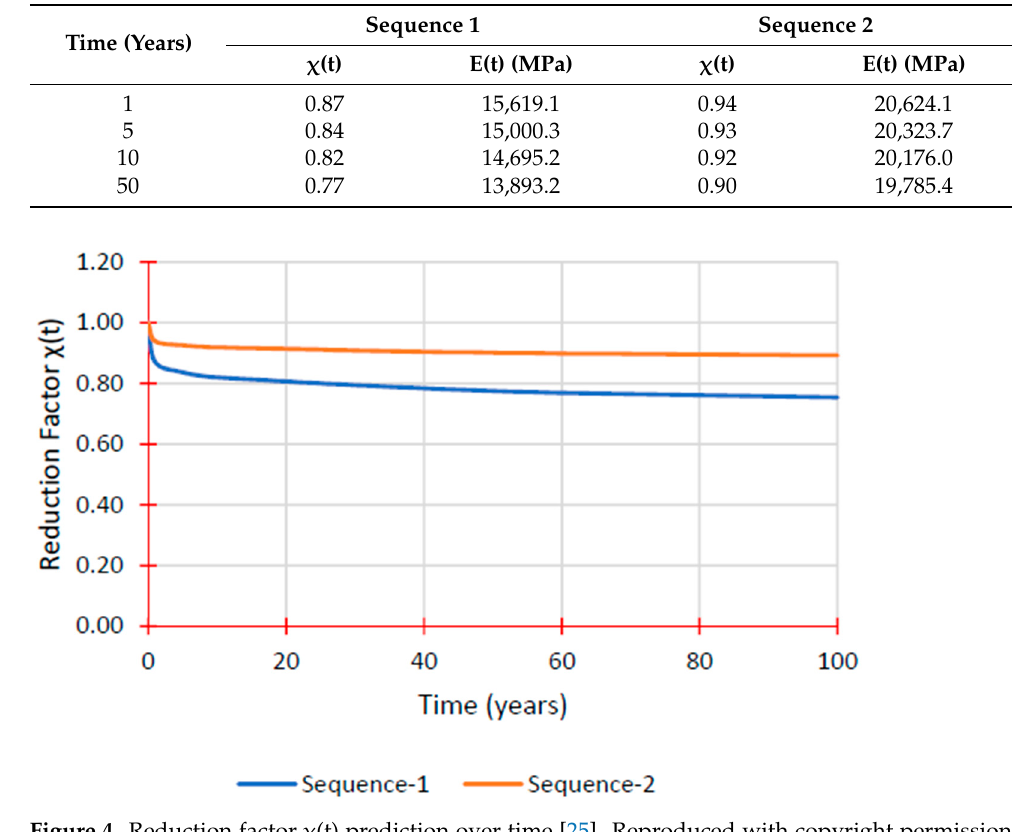
Figure 4. Reduction factor χ (t) prediction over time [25]. Reproduced with copyright permission from Creative Commons Attribution License 3.0.